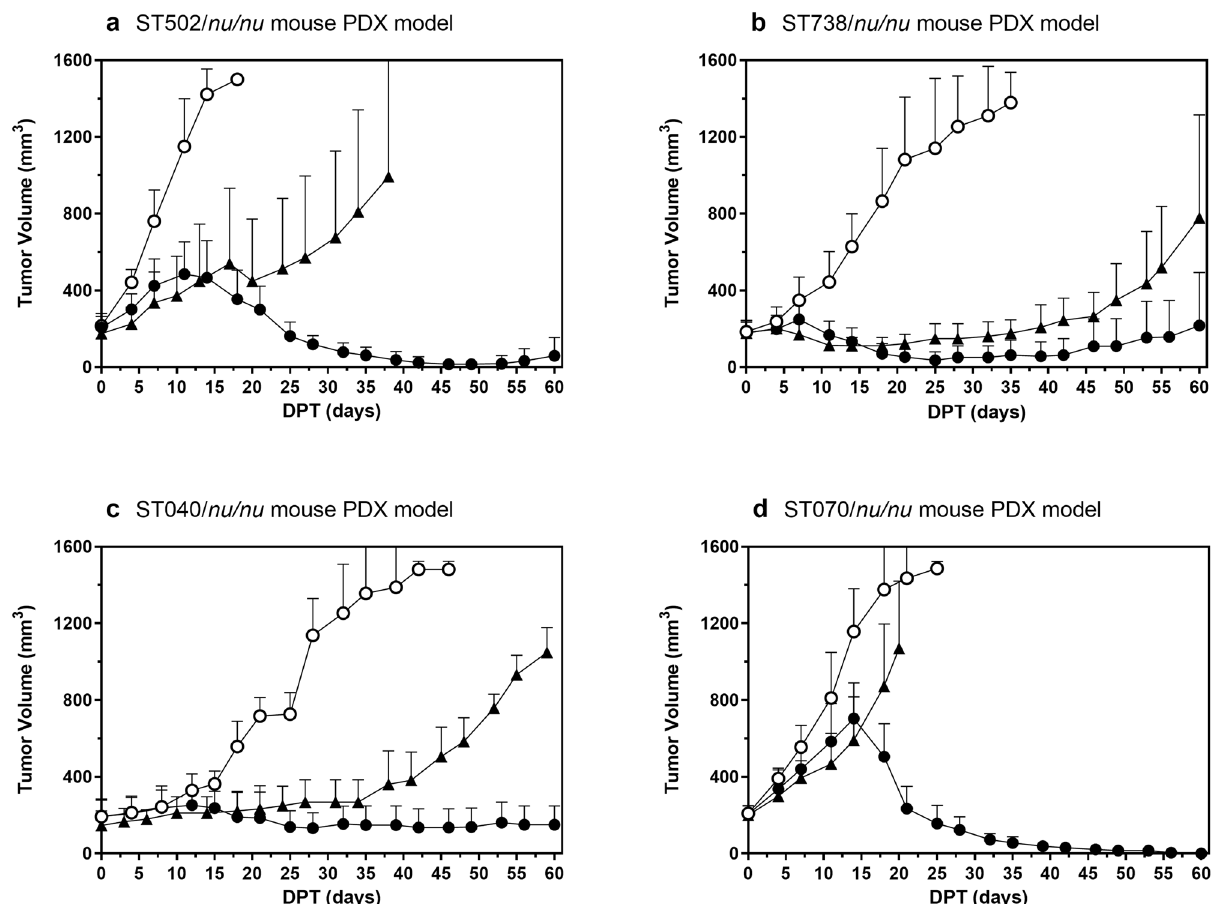
Figure 5. Antitumor effects of EC2629 on patient derived triple negative breast ST502 ( a ), ST738 ( b ), endometrial ST040 ( c ) and ovarian ST070 ( d ) xenograft models in nu/nu mice. Tumor fragments harvested from host animals were inoculated subcutaneously into nu/nu mice and therapy started on randomized animals with tumors in the 112–333 mm 3 ( a ), 112–300 mm 3 ( b ), 78–333 mm 3 ( c ) and 131–266 mm 3 ( d ) range. open circle, untreated controls; filled triangle, eribulin mesylate, 1 mg/kg SIW × 2 weeks ( a , b ) or paclitaxel, 15 mg/kg, SIW × 2 weeks ( c , d ) filled circle, EC2629, 0.27 µmol/kg, BIW × 2 weeks ( a , b , c , d ). Each curve shows the average volume of 3–7 tumors; bars,